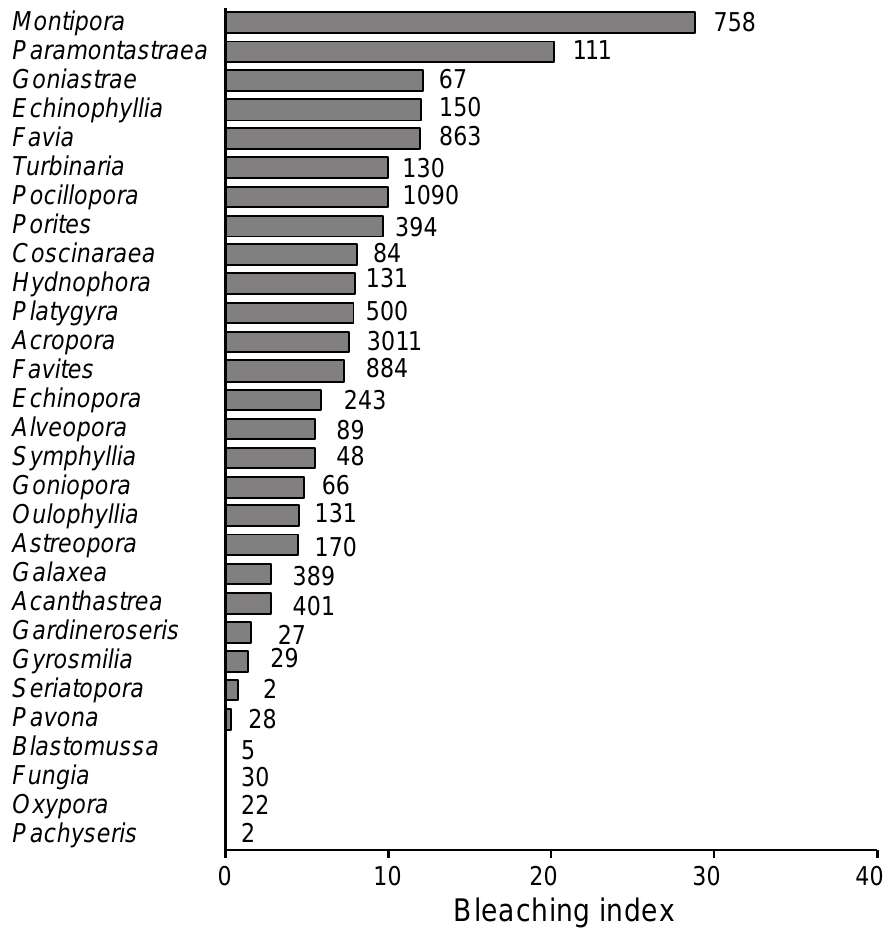
Figure 8. Taxonomic bleaching index for scleractinian genera surveyed across 13 sites on Maputaland high-latitude reefs from 2015 to 2017. Numbers adjacent to bars indicate the total number of colonies assessed. Table 2. Permutational analysis of covariance investigating variation in bleaching index according to latitude, depth, cumulative daily degree heating week (DHW) and year on reefs in the south-west Indian Ocean from 2015 – 2017. Significant effects are indicated in bold ( α = 0.05).